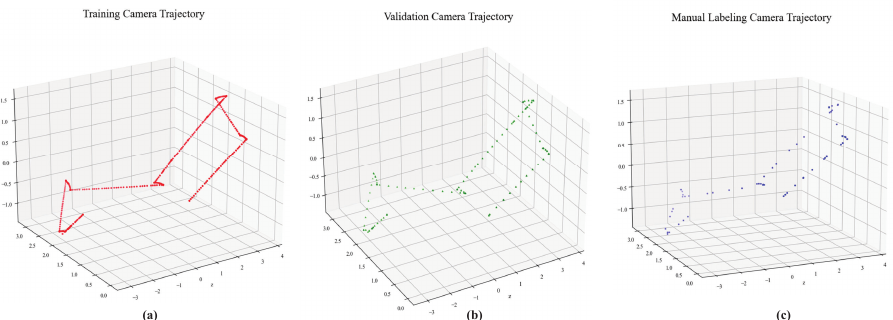
Figure 7. Camera trajectory during the climbing robot collection process. ( a – c ) use red, green and blue dots to represent the viewpoint position information of the training, validation, and human-labeled pictures after the robot captures the